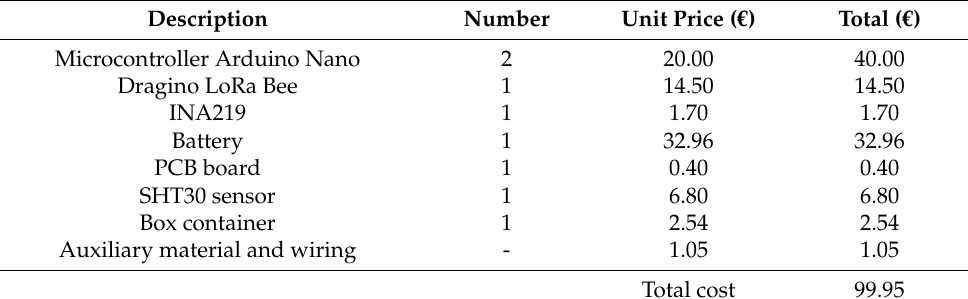
Table 7. Cost of components for the THMDL with a battery power